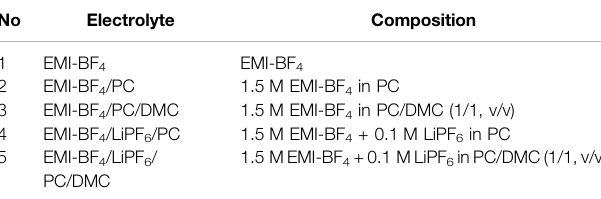
TABLE 1 | Compositions of the investigated electrolytes in the